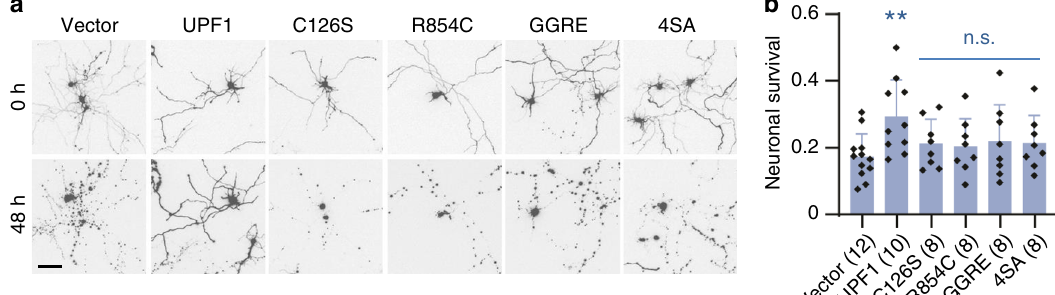
Fig. 5 Overexpression of UPF1, but not NMD-de fi cient UPF1 mutants, reduces PR toxicity in primary neurons. a Representative images of mApple- labeled primary cortical neurons expressing BFP (vector), UPF1, or NMD-de fi cient UPF1 mutants before and after treatment of 2 µ M PR 20 for 48 h. Scale bar, 100 µ m. b Quanti fi cation of neuronal survival after 48 h of PR 20 treatment. Numbers of independent experiments are indicated in parenthesis. Data are presented as mean values± SD. ** P < 0.01; n.s., not signi fi cant, two-sided paired t tests. Source data and exact P values are provided in the Source Data